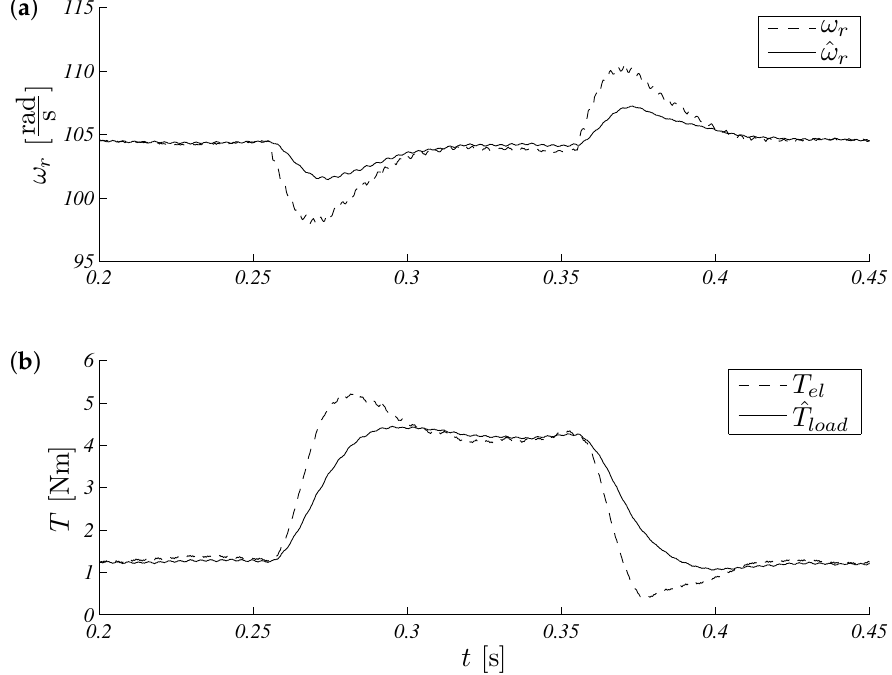
Figure 9. Unscented Kalman filter speed ( a ) and torque ( b ) response for load torque T l =